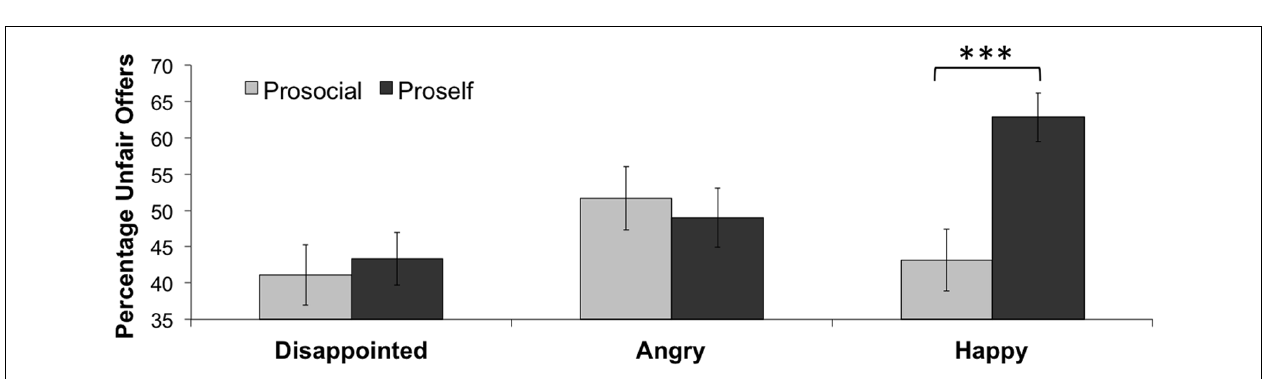
FIGURE 1 | Percentage of unfair offers for the three emotions, separate for three age groups. Single asterisk ( ∗ ) indicates p < 0.05; double asterisk ( ∗∗ ) indicates p < 0.01.